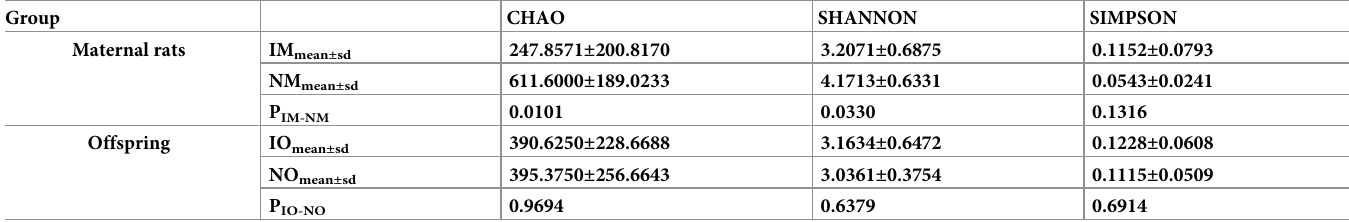
Table 2. The alpha diversity analysis of microbiome in feces of maternal rats and offspring.